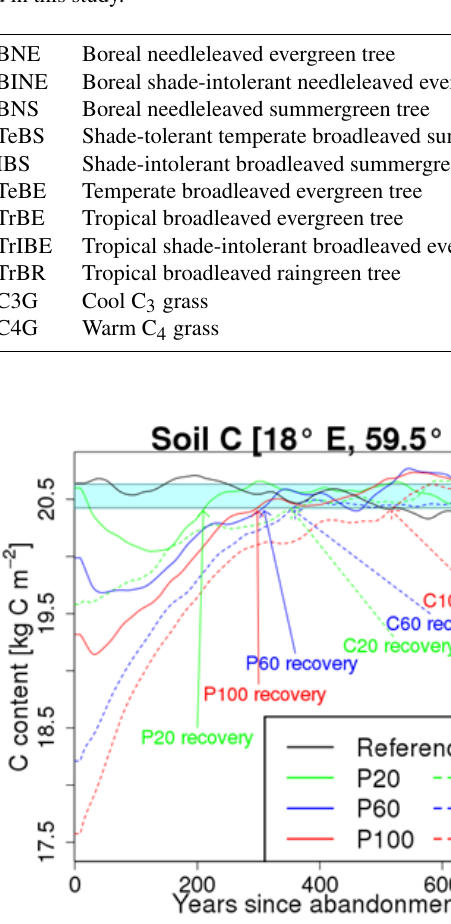
Figure A1. Soil C for the six simulations after conversion to natural vegetation at one single example site to illustrate how recovery time was calculated according to our definition. The cyan-shaded area corresponds to reference simulation mean ± 1 σ . When soil C exceeds the mean − 1 σ threshold and the time of the minimum (which in this case is located in the first 200 years and below the mean − 1 σ threshold for all six simulations) is passed, recovery is